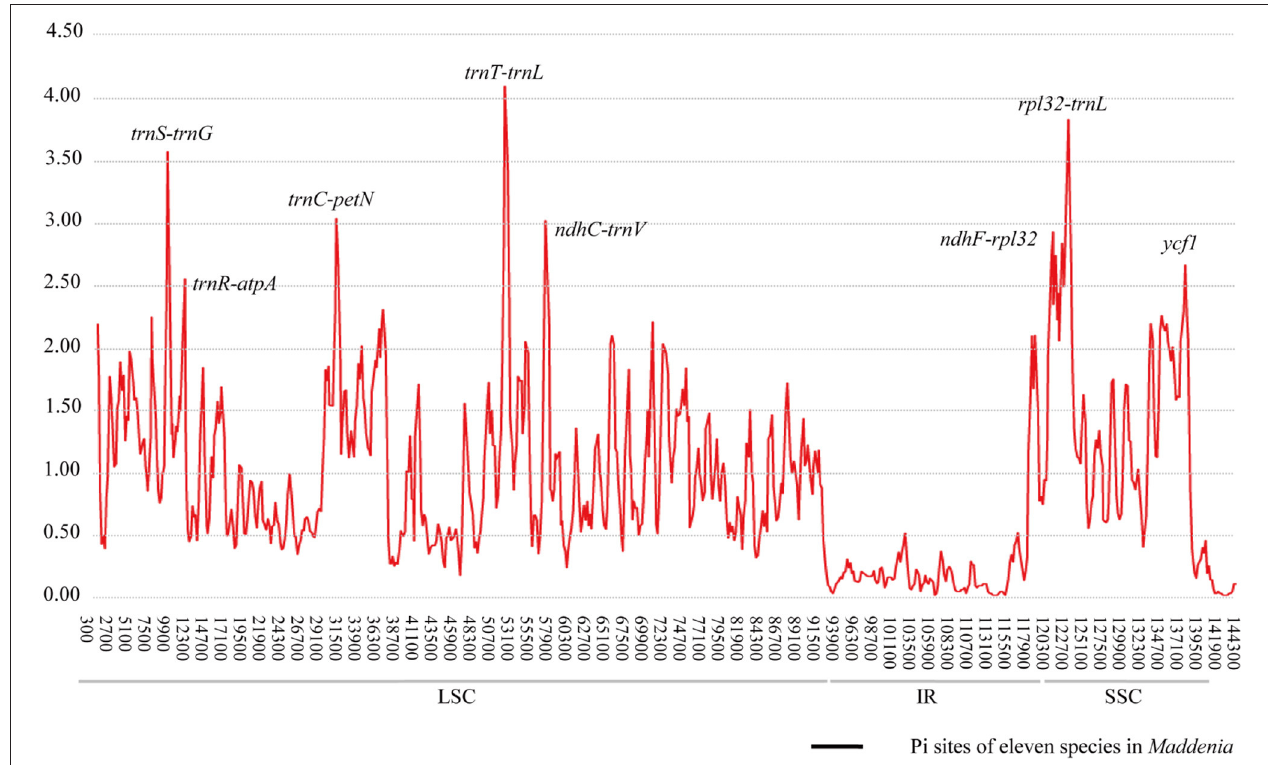
FIGURE 5 | Sliding window analysis of the plastomes of samples.